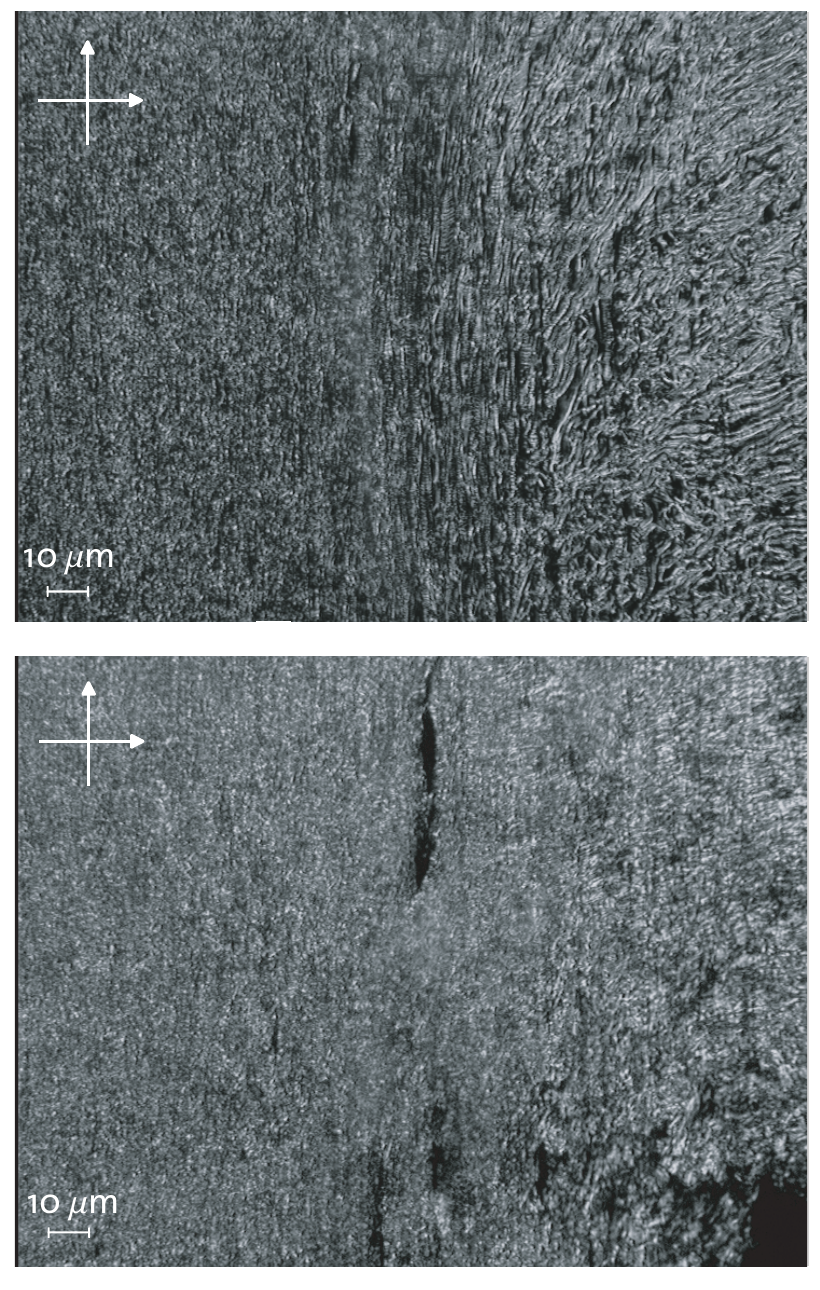
Figure 10 (above): Shear induced texture development in a sample produced at a shear rate of 5 s-1 for Vectra B 950 (between crossed polarizers). Figure 11 (below): Shear induced texture development in a sample produced at a shear rate of 5 s-1 for Vectra L 950 (between crossed